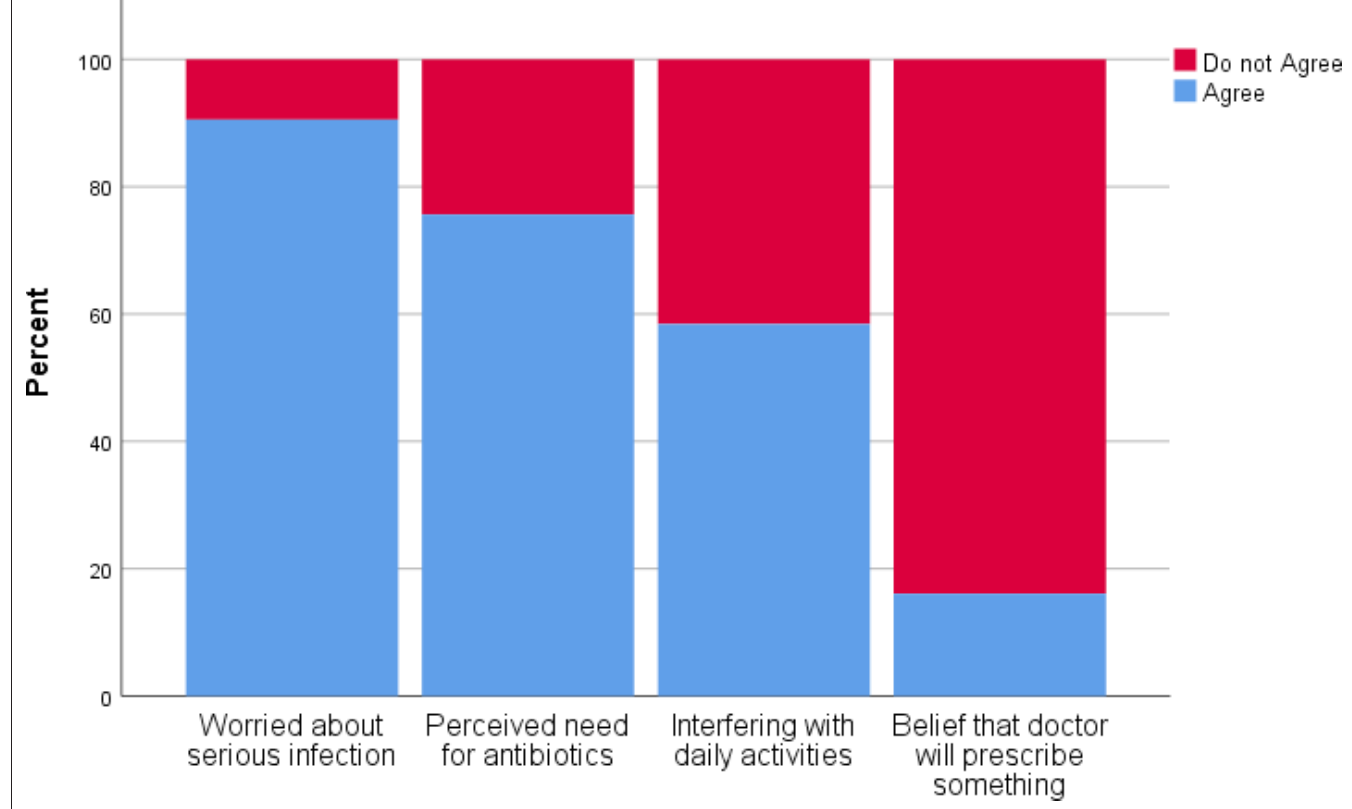
Figure 1 Public perceptions of reasons to consult a healthcare professional for a respiratory tract